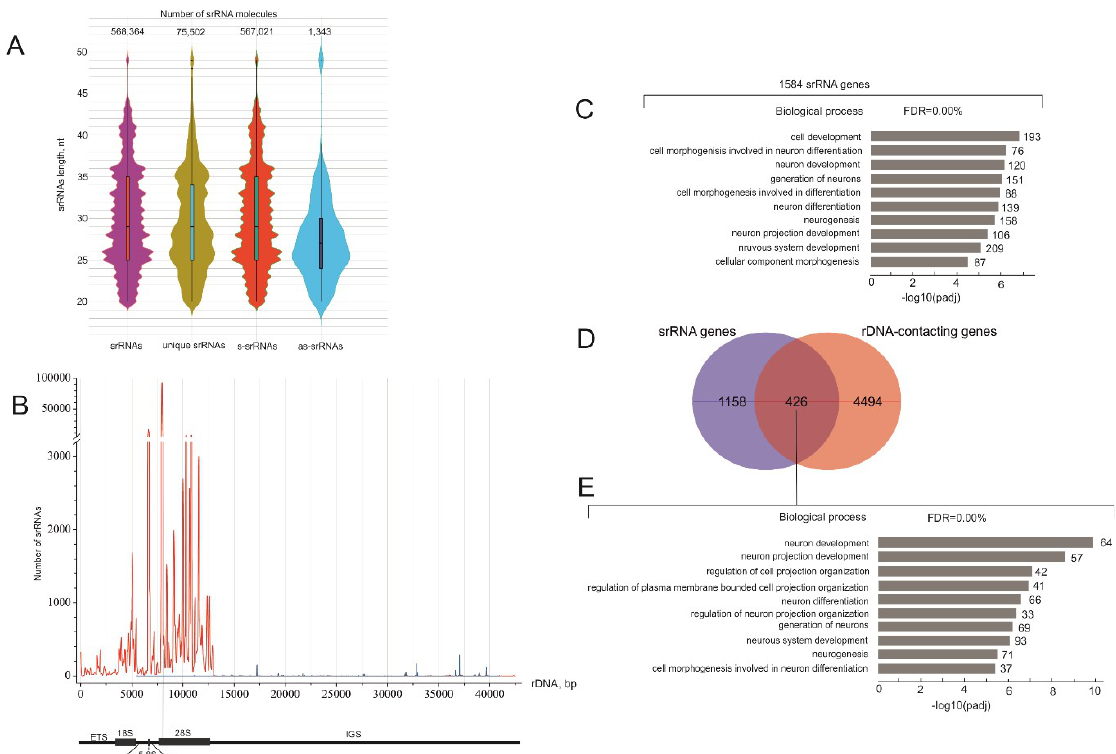
Figure 1. Characterization of srRNAs and their target genes. ( A ) Violin presentation of srRNA lengths and abundance, including all isolated molecules, unique molecules (without exact copies), and sense and antisense molecules. The complete data are presented in Table S1. ( B ) The distribution of sense (red curve) and antisense (blue curve) srRNAs along the length of a 43 kb rDNA unit. The vertical line rising from the 28S gene indicates the highest peak of srRNAs. ( C ) The top ten Gene Ontology (GO) biological process associations of srRNA target genes. The values to the right of the bars show the number of srRNA target genes associated with a process. The complete list of srRNA target genes is shown in Table S1. Table S2 shows the results of the GO search. ( D ) A Venn diagram showing the intersections between srRNA target genes and rDNA-contacting genes [9]. Table S3 shows the list of overlapping genes. ( E ) The top ten GO biological process associations of 426 genes are shown in ( D ). The values to the right of the bars show the number of srRNA target genes associated with a